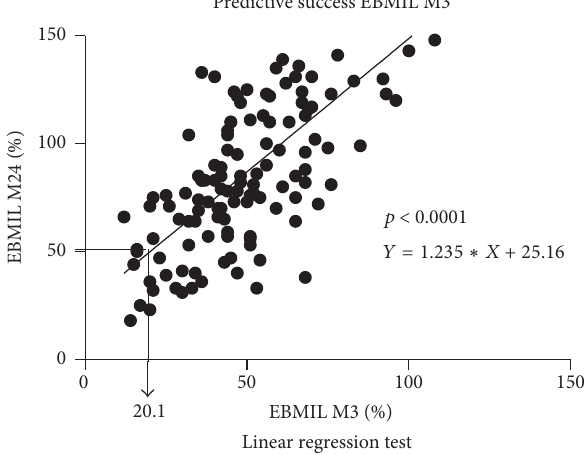
Figure 4: Determination of the success of predictive Excess Body Mass Index Loss (% EBMIL) at M3 (linear regression analysis). EBMIL: Excess BMI Loss; M3: at 3 months; M24: at 24 months.